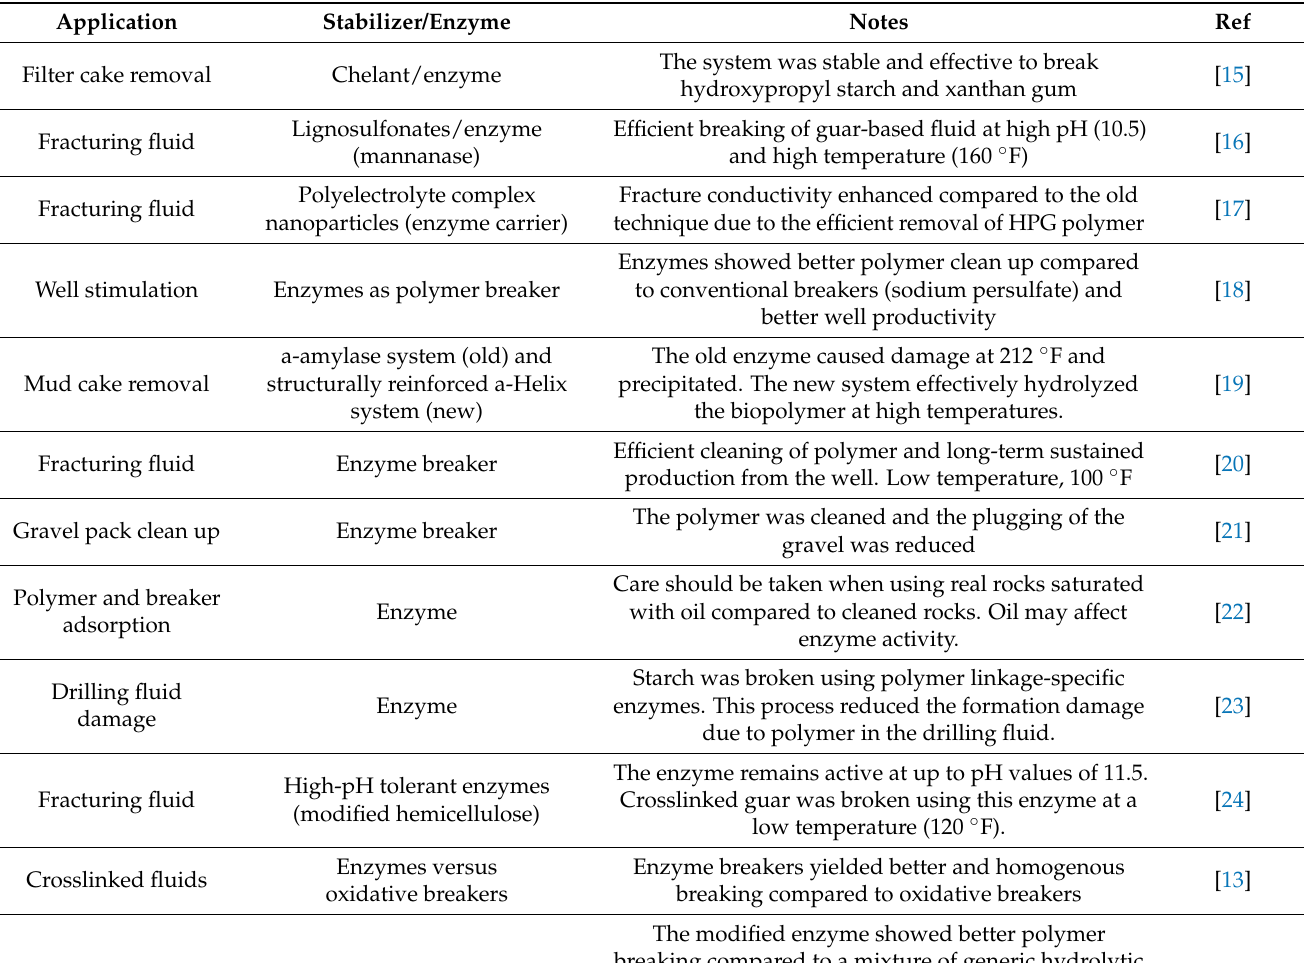
Table 1. Enzymatic applications in upstream oil and gas